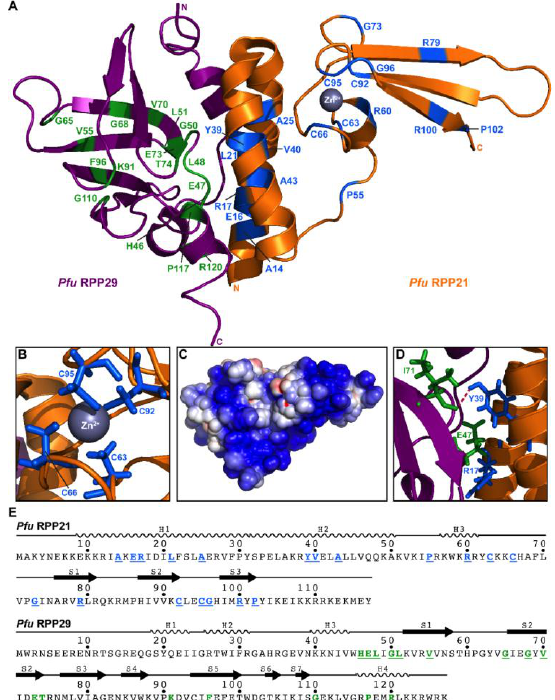
Figure 2. Highly conserved residues and protein–protein interactions in Pfu RPP21 and RPP29. ( A ) Tertiary structure of the Pfu RPP21 ‚ RPP29 binary complex (PDB: 2KI7 [28]). All positions with ě 80% identity from the alignment of 71 representative archaeal RPP21 and RPP29 sequences are highlighted; ( B ) Zinc-ribbon motif in RPP21 that is universally conserved; ( C ) Electrostatic potential map of the surface of the RPP21 ‚ RPP29 complex; the orientation is identical to that in panel A; ( D ) Protein–protein interactions previously identified [28]: I71 in RPP29 and Y39 in RPP21 participate in a hydrophobic interaction while E47 in RPP29 and R17 in RPP21 appear to form an intermolecular salt bridge; ( E ) Location of conserved residues (underlined and using the same color scheme as in (A)) and secondary structure elements in the sequences of RPP21 and